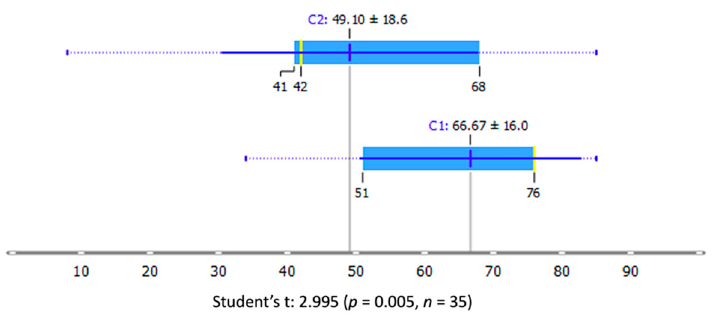
Figure 8. Clustering analysis from Inception V3 deep learning features based on combined superficial and deep OCT-As. The mean 1-year BVCA for C1 and C2 was 49.1 and 66.67, respectively, with a t -test p -value equal to 0.005. The yellow lines show the median values. 1 year, is reported in Figure